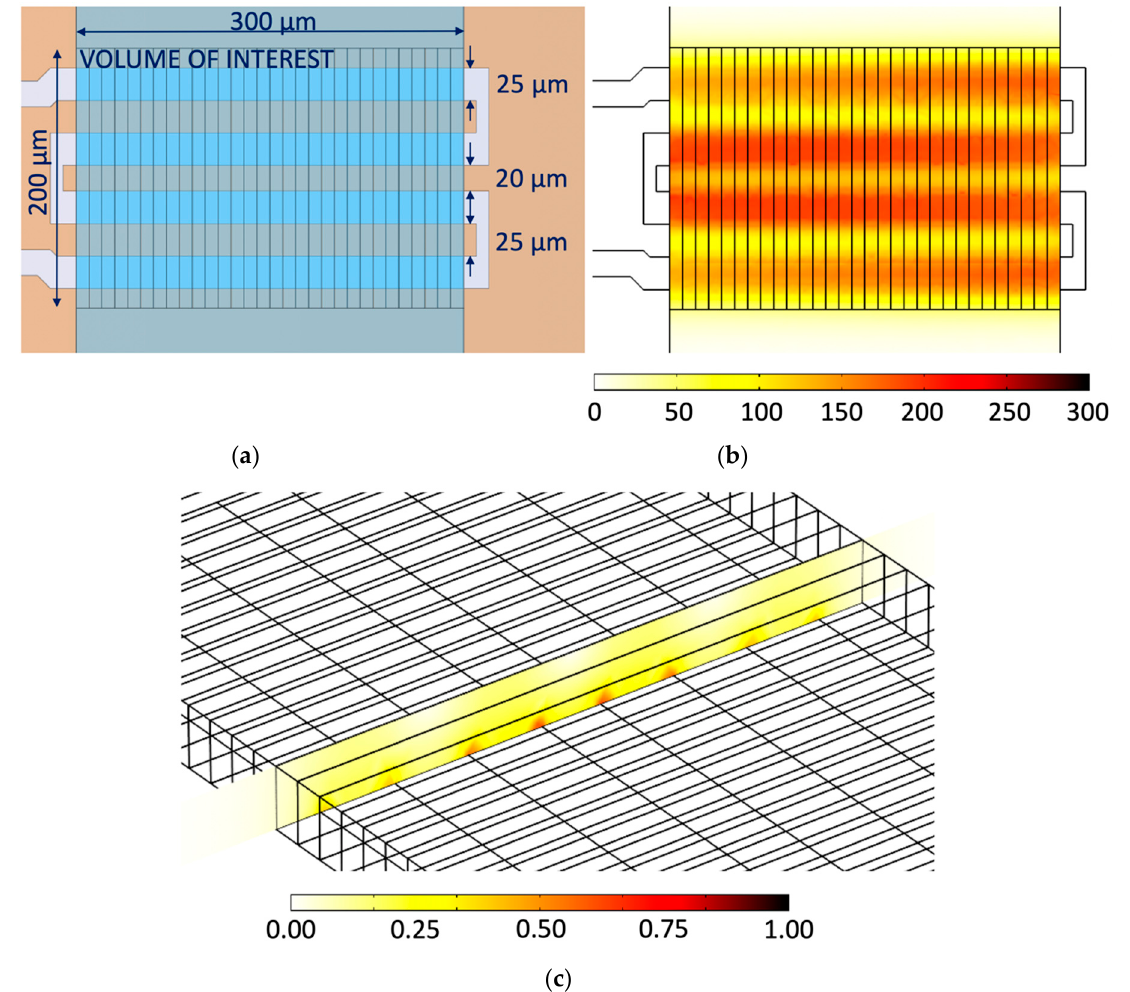
Figure 2. ( a ) The final layout of the IDC heater obtained in COMSOL simulations; ( b ) The electric field in kV/m in the middle of the channel in the XY plane—10 µm above the heater; ( c ) The electric field in MV/m in the middle of the fluidic channel in the XZ plane.